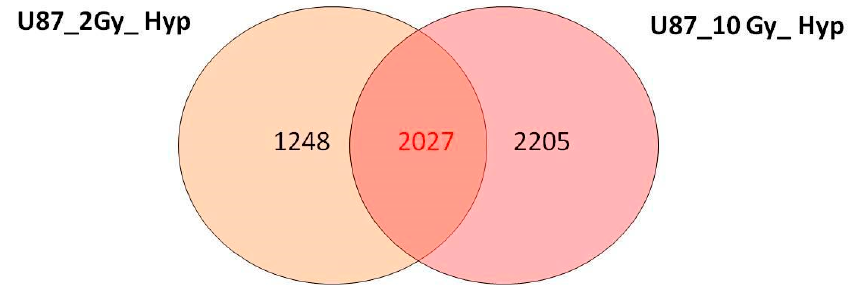
Figure 2. Venn diagrams showing the number of unique and shared differentially expressed genes (DEGs) after exposure to 2 and 10 Gy of PT under acute hypoxia.